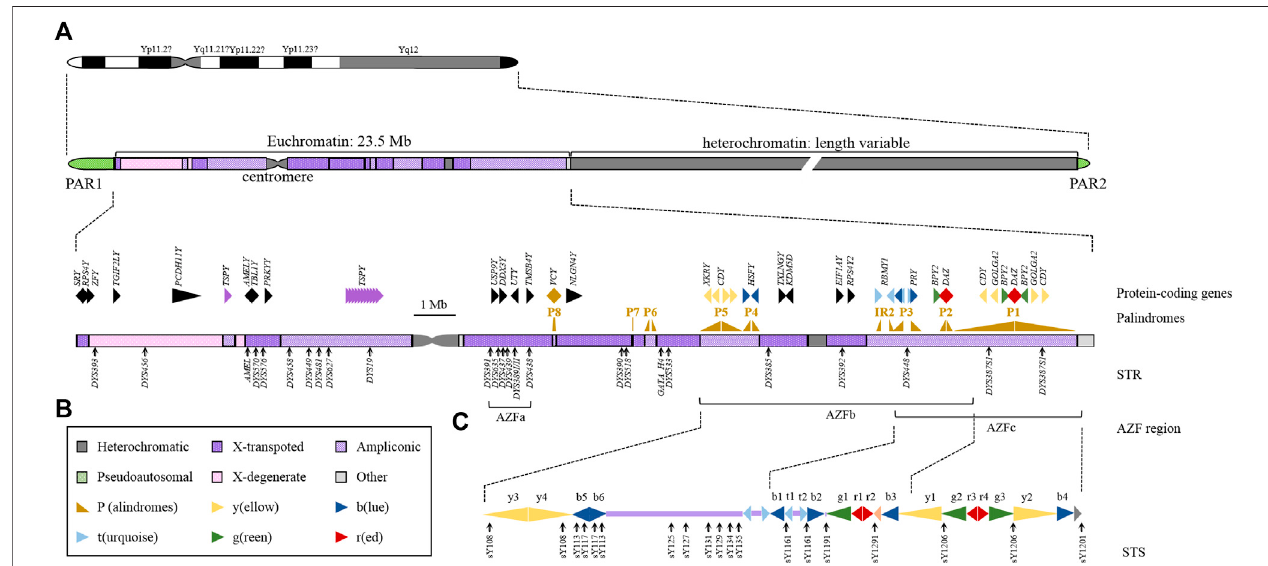
FIGURE 1 | Structural and Genetic Markers of the Y Chromosome. (A) Ideogram of the human Y chromosome. Different structures of chromosomes are represented by different colours. (B) Expanded view of the human MSY euchromatin. The arrowheads indicate the transcriptional direction of the palindromes and genes. The black solid triangles show the single-copy genes, and the colours represent the multicopy genes. The gene name is marked above the symbol. The black arrowsbelowthechromosomesindicatethelocationsofSTRsusedinforensicscienceandtheirnames. (C) SchematicorganizationoftheAZFbandAZFcregion. Repeating units are represented by solid triangles of different colours, and arrowheads point to the transcriptional direction. The black arrows below the chromosomes indicate the locations of STSs and their names.